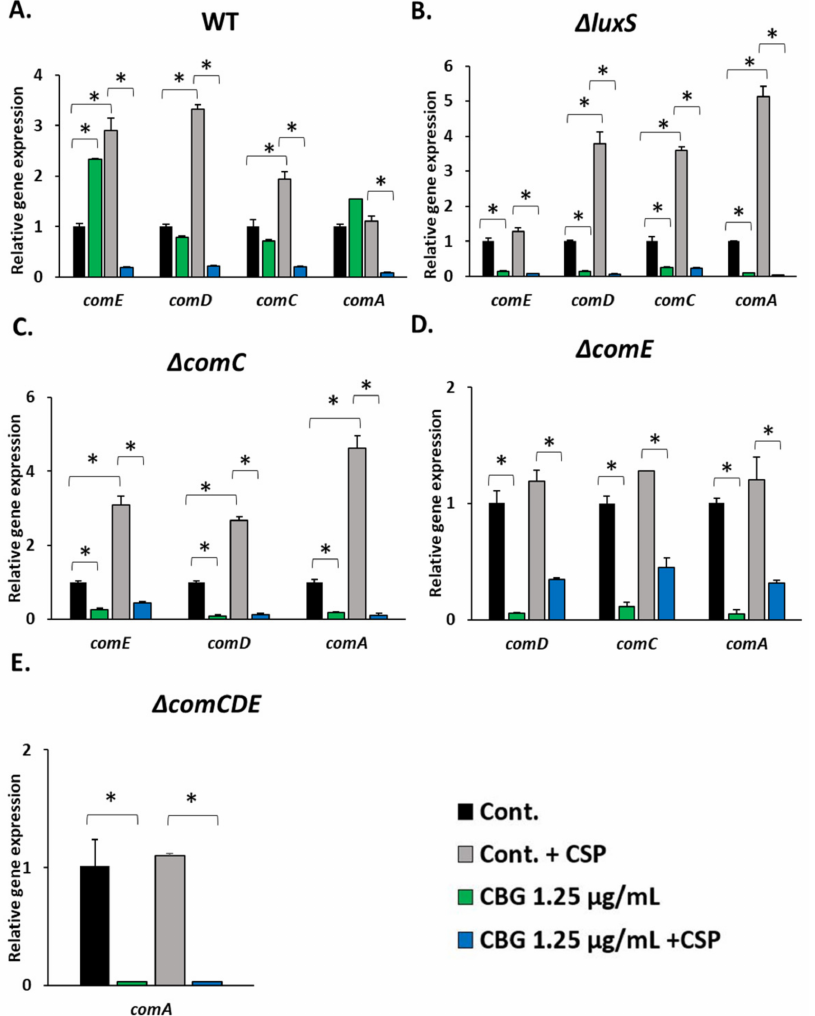
Figure 4. CBG antagonizes the 21-CSP-induced gene expression of comCDE genes. ( A – E ). Expression of comCDE genes in various S. mutans strains incubated in the absence or presence of 1.25 µ g/mL CBG and/or 1 µ g/mL 21-CSP for 4 h in comparison to control as determined by real-time PCR using respective primers. ( A ). WT; ( B ). ∆ luxS ; ( C ). ∆ comC ; ( D ). ∆ comE ; and ( E ). ∆ comCDE . n = 3; * p <